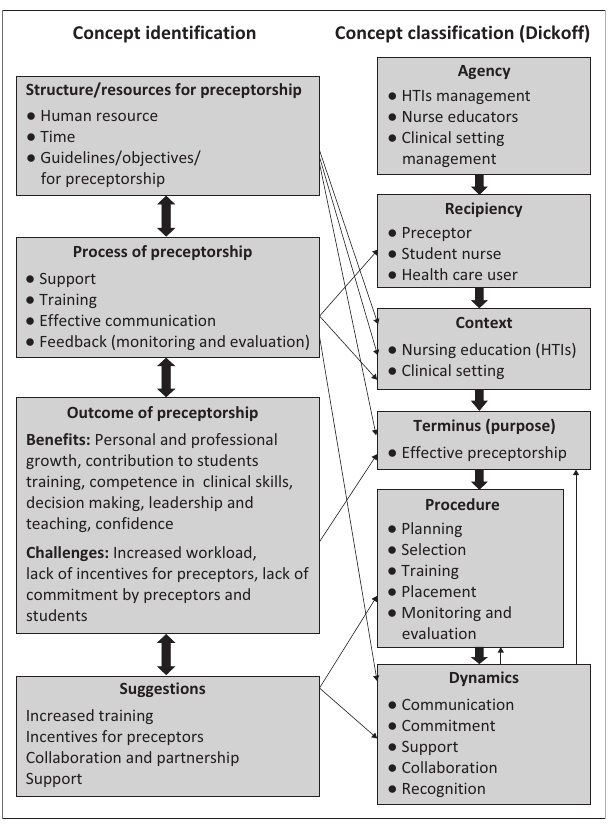
FIGURE 1: Classification of the concepts according to Dickoff’s